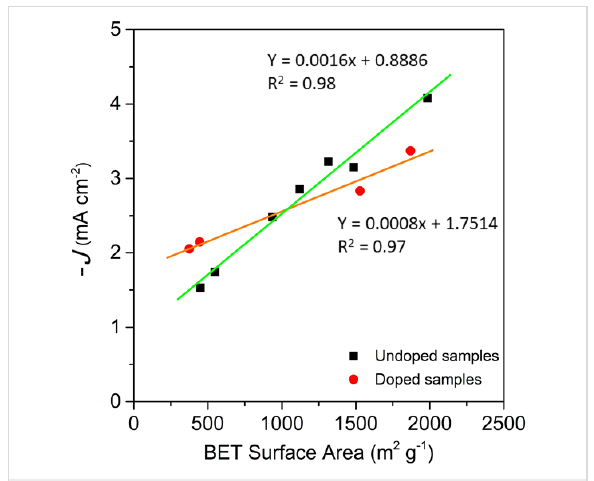
Figure 8: Relationship between BET surface area and limiting current density of undoped and doped samples.